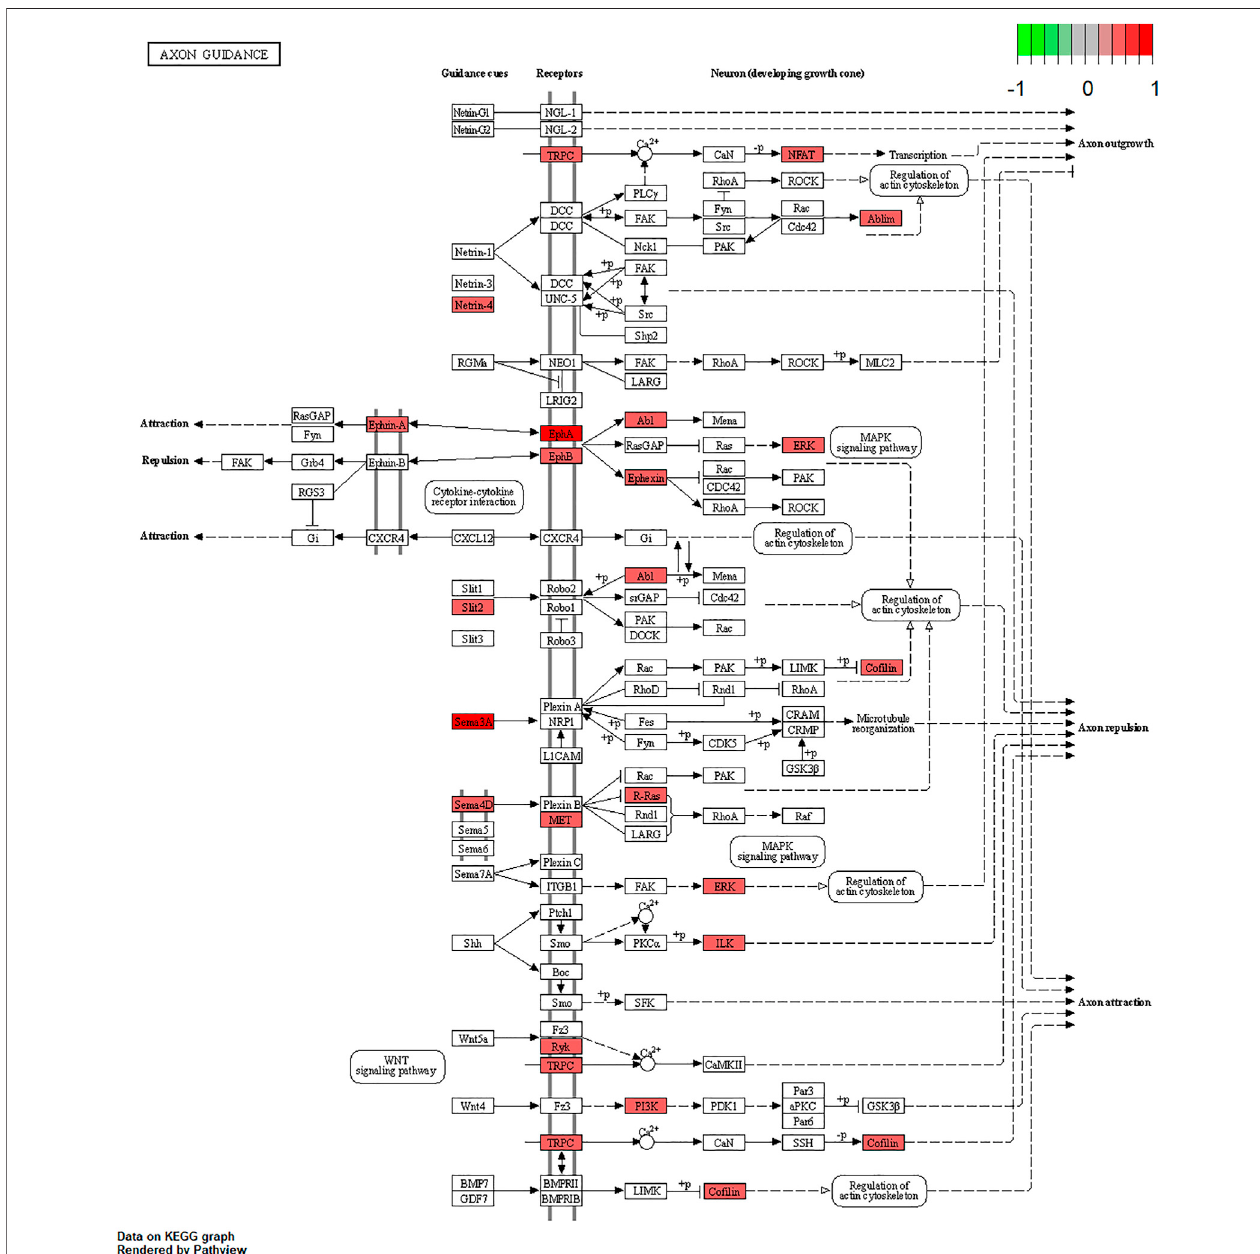
FIGURE 11 | Pathway of axon guidance. Note: Visualization of a pathway signi fi cantly enriched by KEGG analysis and performed in “ pathview ” of R software.